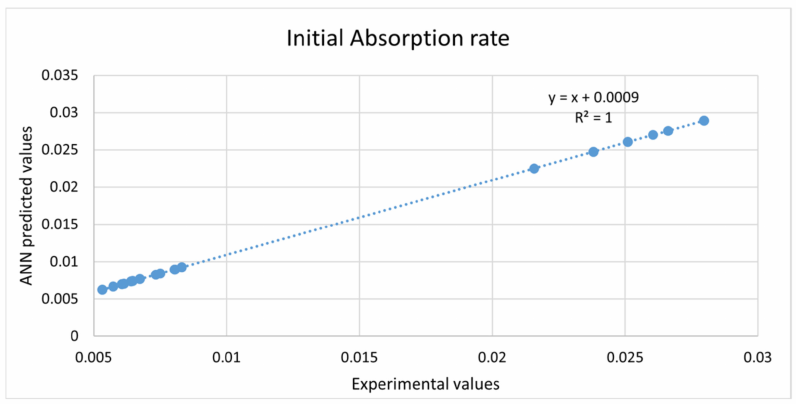
Figure 16. Initial absorption rate—correlation between ANN and experimental